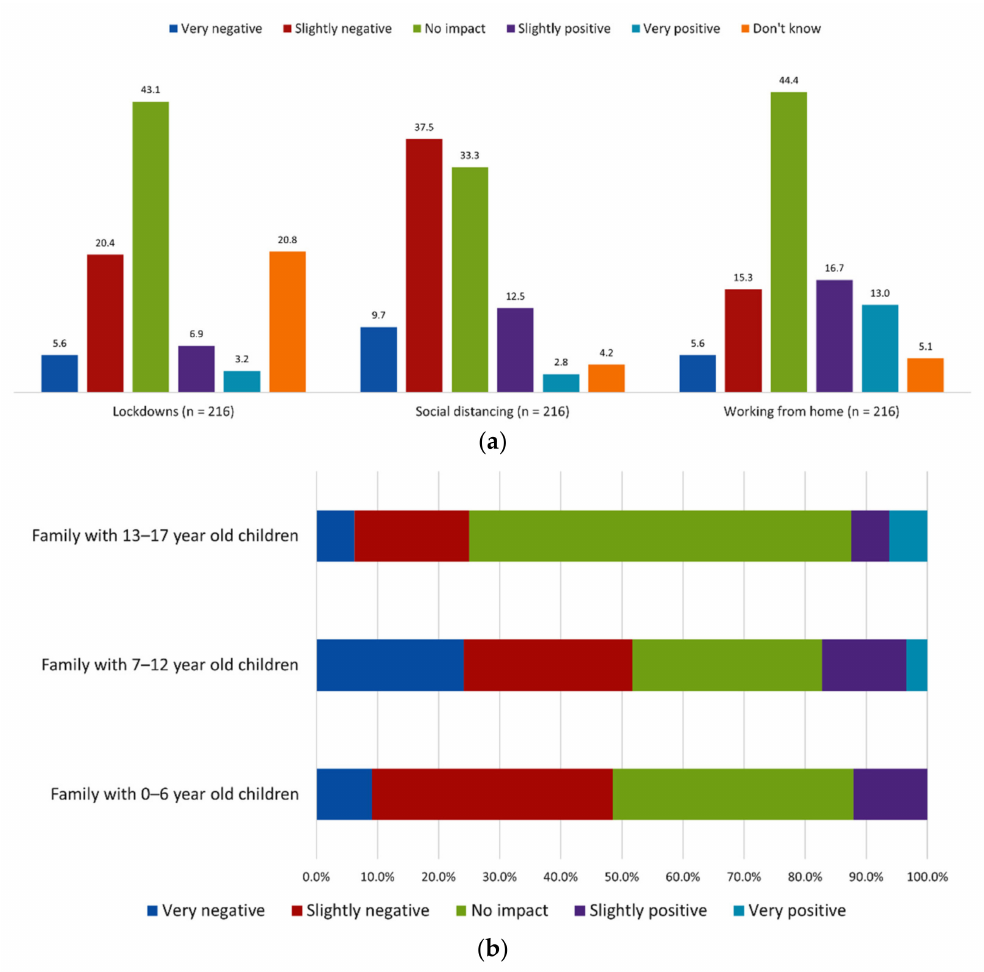
Figure 4. Impact on respondent’s personal wellbeing of COVID-19 restrictions: ( a ) Lockdowns ( n = 216), Social distancing ( n = 216), and working from home ( n = 216) and ( b ) combining full-time remote (home) working with home schooling of children ( n =